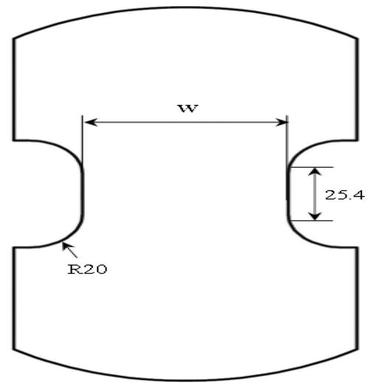
Specimen geometry for formability characterization. The diameter of the blank is 225.4 mm. All dimensions are in millimeters.